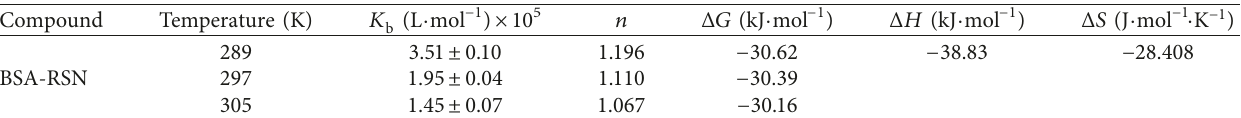
Table 2: Binding constants, number of binding sites, and thermodynamic parameters for the interaction of BSA with RSN at different temperatures (pH 7.40).